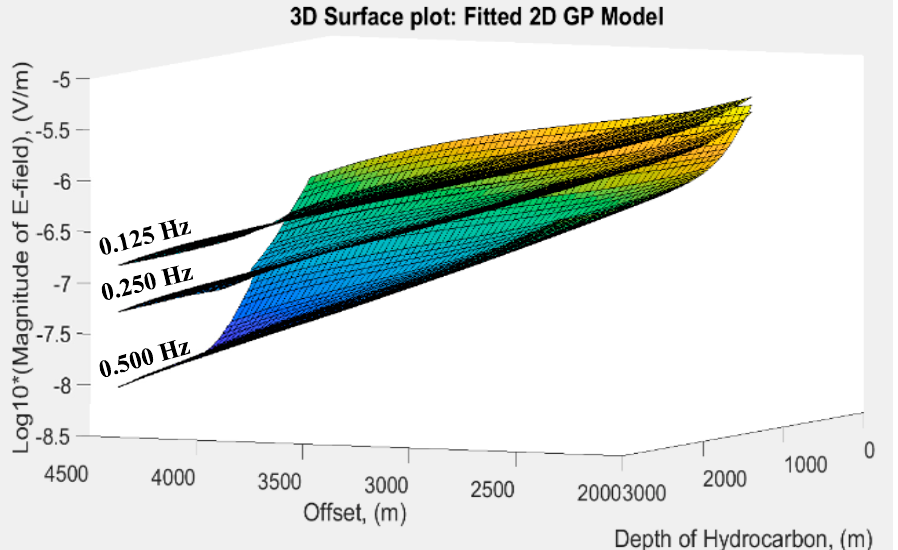
Figure 10. Combination of 3D surface plots of the 2D GP models for frequencies of 0.125, 0.25, and 0.5 Hz. The x - axis is the offset which is the source–receiver separation distance, the y-axis denotes the depth of hydrocarbon (250–2750 m), and the z-axis represents the log10 of magnitude of the electric field.